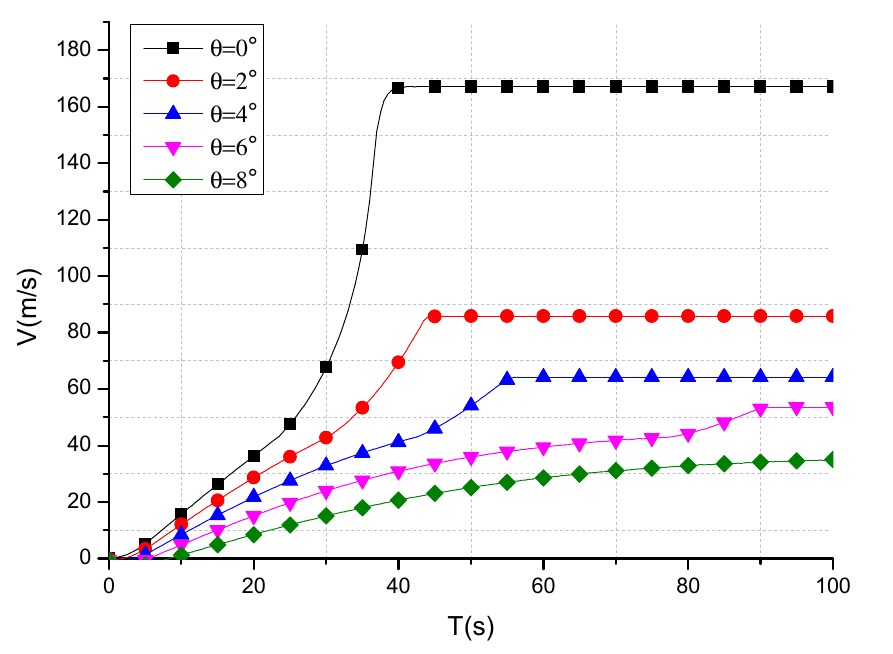
Figure 10. Flight data at different pitch angles.